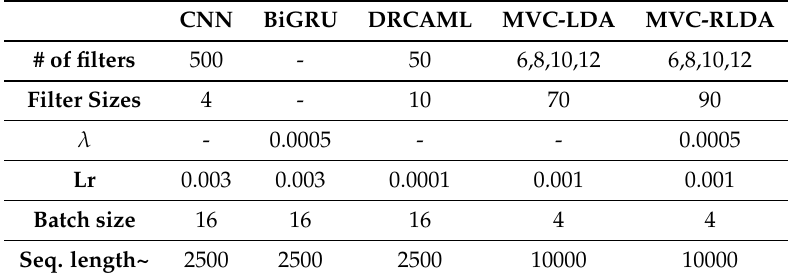
Table 2. Optimal hyperparameter values obtained on the development set of the MIMIC-III dataset. CNN BiGRU